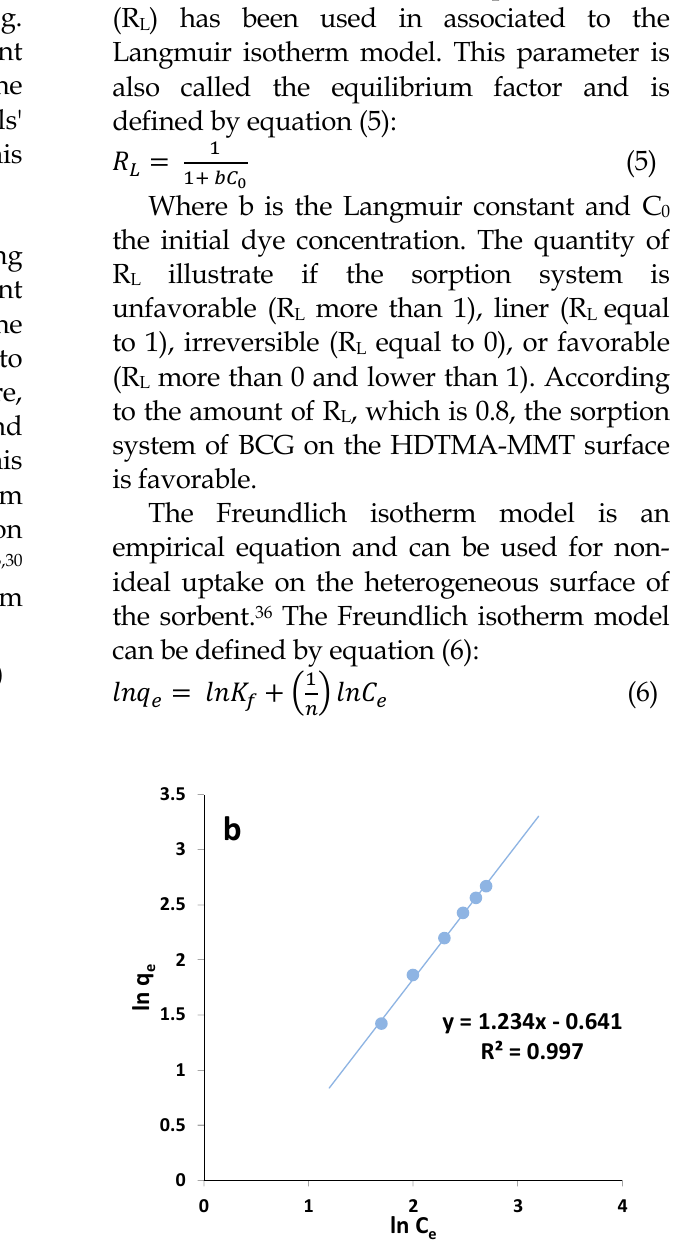
Figure 5. The effect of adsorbate concentration on sorption (contact time = 20 minutes, adsorbent dosage = 1 g/l, and solution pH = 3) and (b) Freundlich isotherm